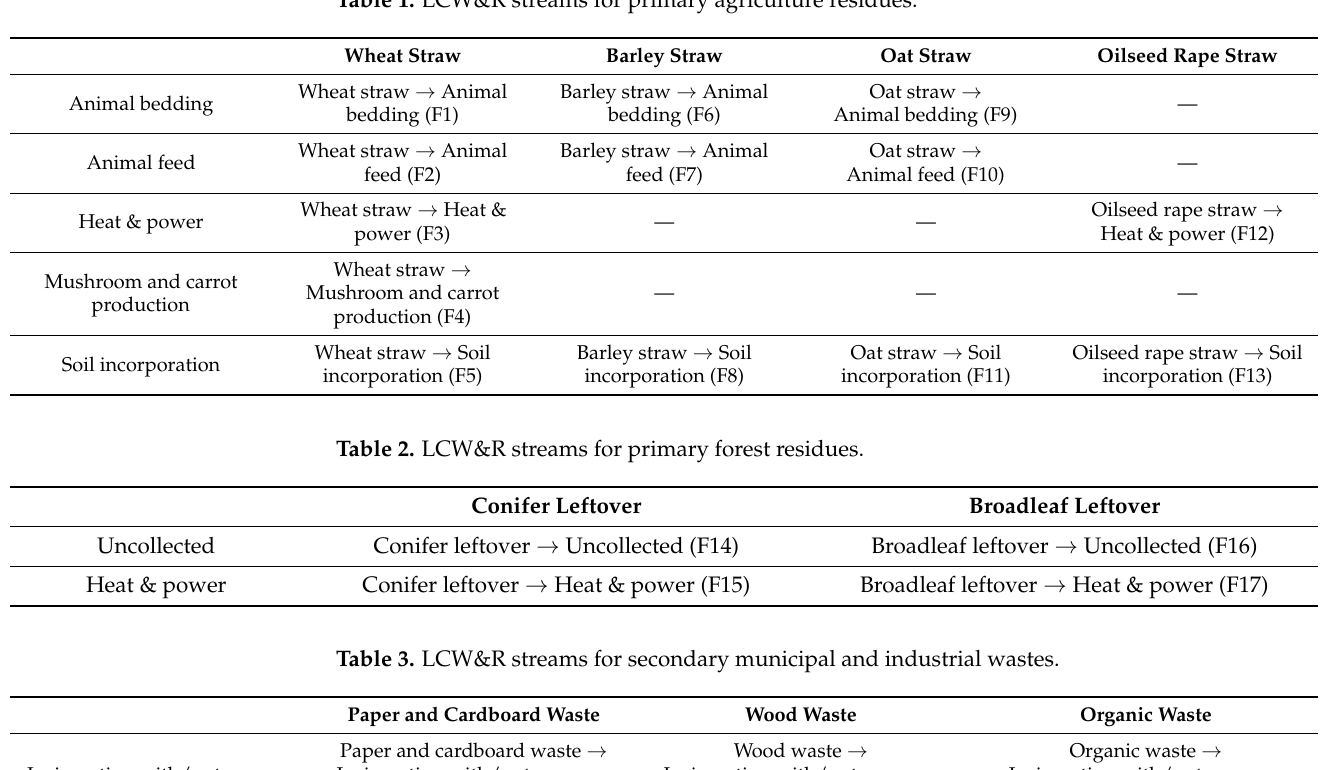
Table 1. LCW&R streams for primary agriculture residues.